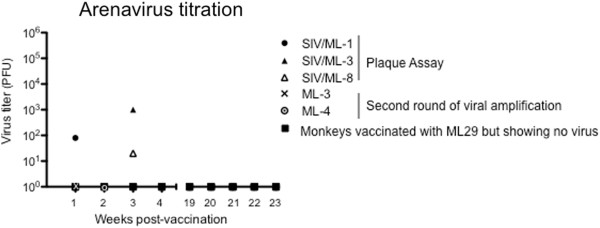
Detection of arenavirus in ML29-inoculated macaques. Virus titration by plaque assay revealed that only three animals (SIV/ML-1 •, SIV/ML-3▴, and SIV/ML-8 ▵) showed low viremia by week 3 after inoculation with ML29. Negative samples were tested by a second round of amplification (see Methods), showing traces of virus in two animals (ML-3 × and ML-4 ⊙), the remaining animals (▪) tested negative until the end of the study.